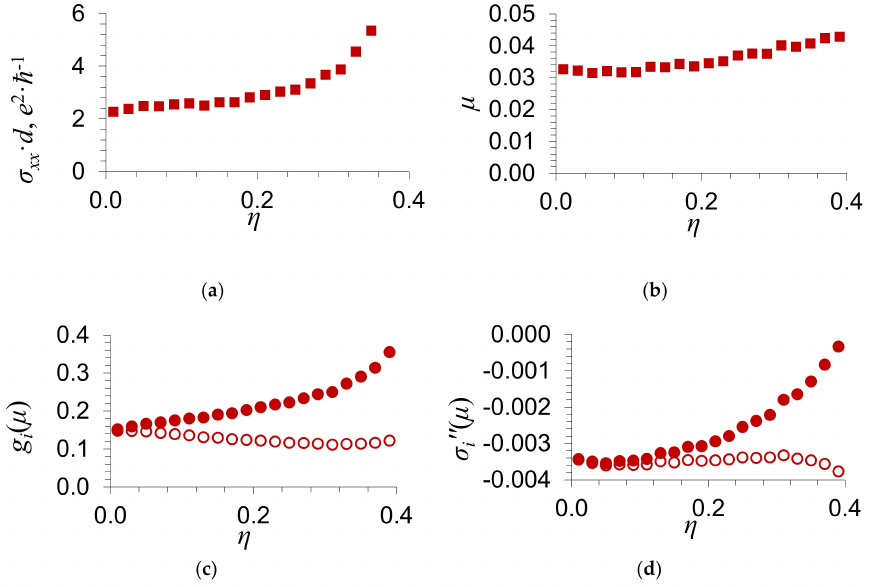
Figure 4. Dependence of ( a ) the electrical conductance of graphene σ xx ; ( b ) the Fermi level µ ; ( с ) the partial density of states g i ( µ ) at the Fermi level; and ( d ) the imaginary part of the coherent potential σ (cid:48)(cid:48) ( µ ) at the Fermi level on the order parameter of impurity atoms η . The substitutional impurity i concentration y = 0.2 and the scattering potential δ / w = − 0.2. Circles correspond to g 1 ( µ ) and σ (cid:48)(cid:48) of the first sublattice, in which the impurity atoms are located in the case of full order. Filled circles ( µ ) for the second sublattice. show g 2 ( µ ) and σ (cid:48)(cid:48) 2